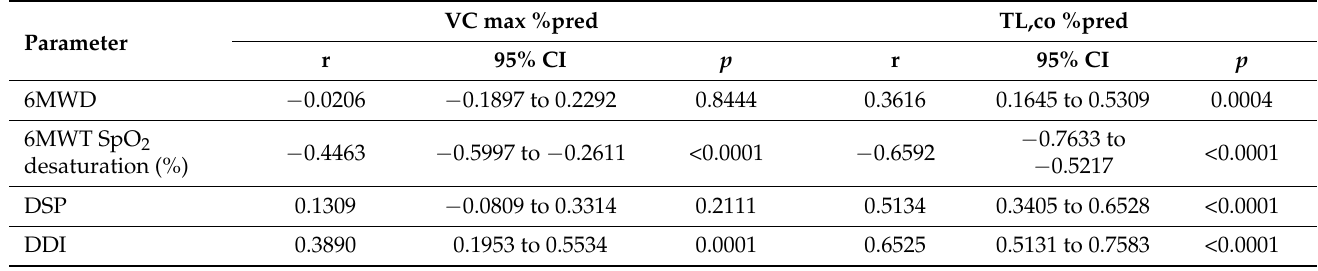
Table 4. Correlation between baseline 6MWT and PFT parameters (Spearman).